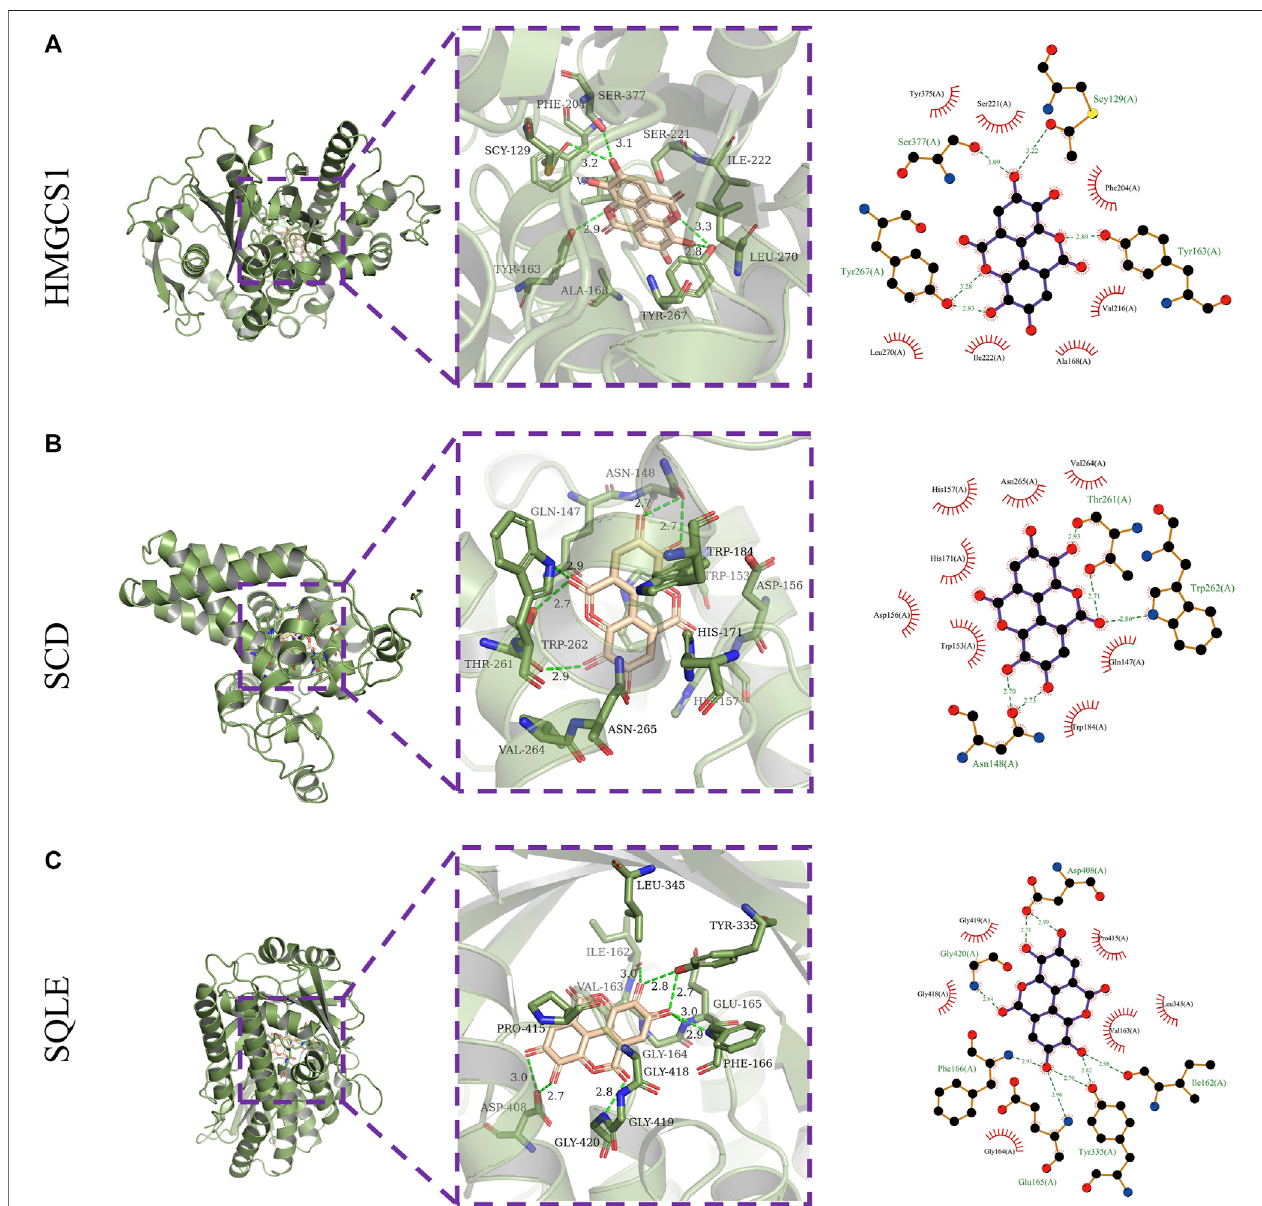
FIGURE 2 | Molecular docking. Three-dimensional (left) and two-dimensional (right) ligand interaction diagrams of ellagic acid and the original ligands of HMGCS1 (A) , SCD (B) , and SQLE (C) .